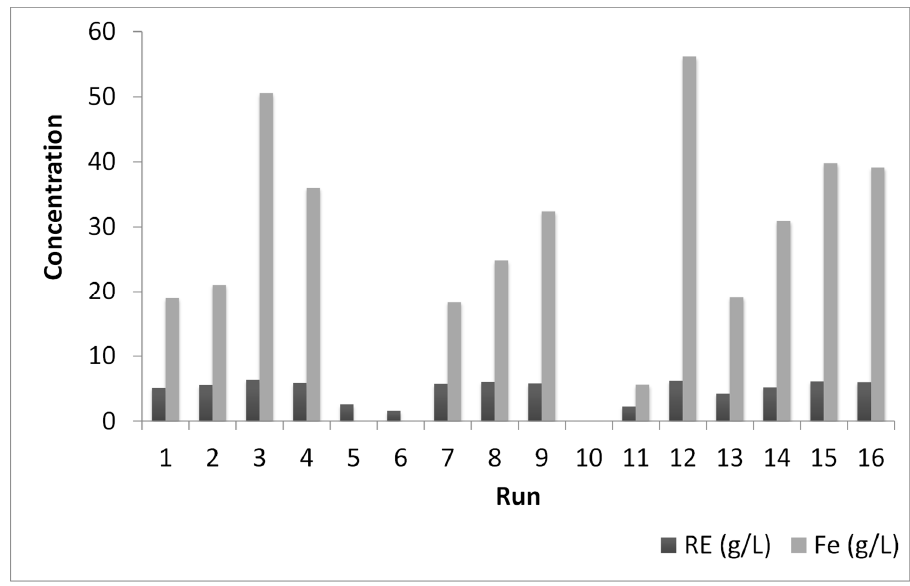
Figure 11. Concentration of REE and Fe (g/L)—mathematical modeling experiments.